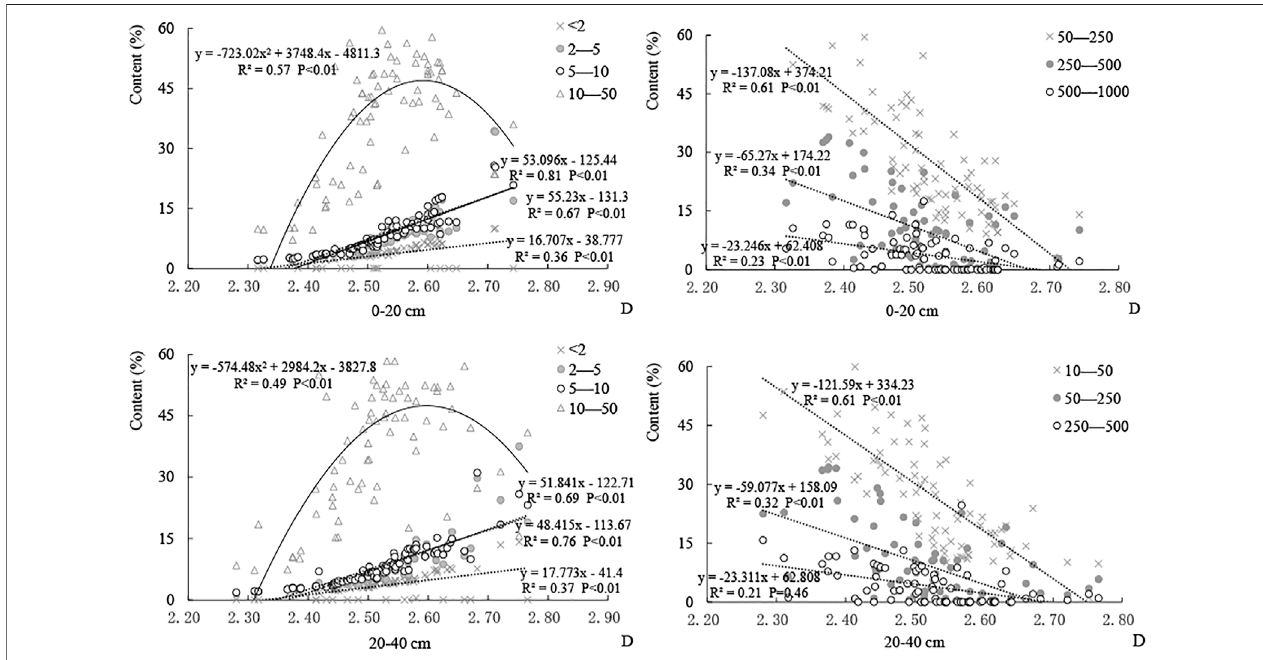
FIGURE 4 | Content relationship between D and the particle size in the farmland (F) in the fl ooded area.